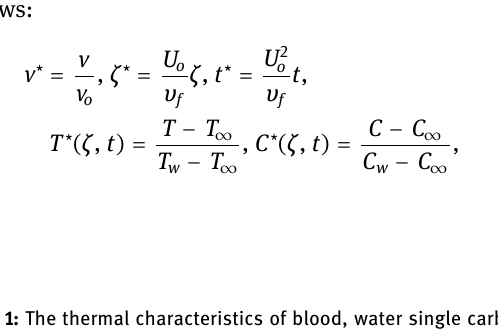
Table 1: The thermal characteristics of blood, water single carbon - nanotubes, and multiwall carbon